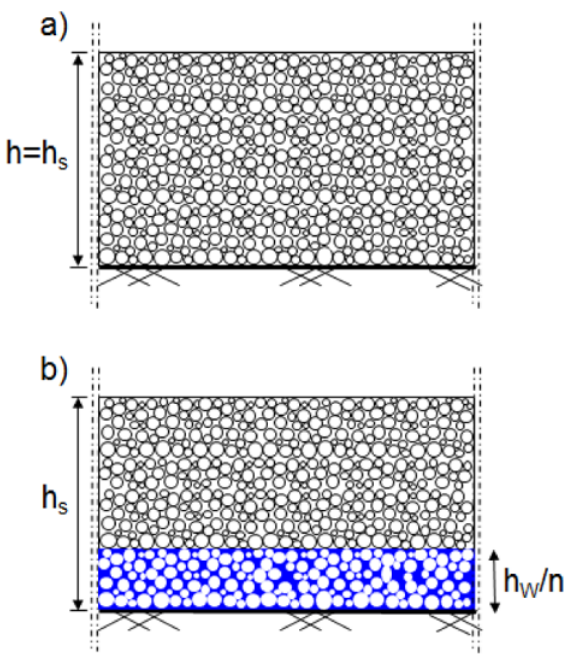
Fig. 1. Snowpack in dry condition (a) , and in wet condition (b)